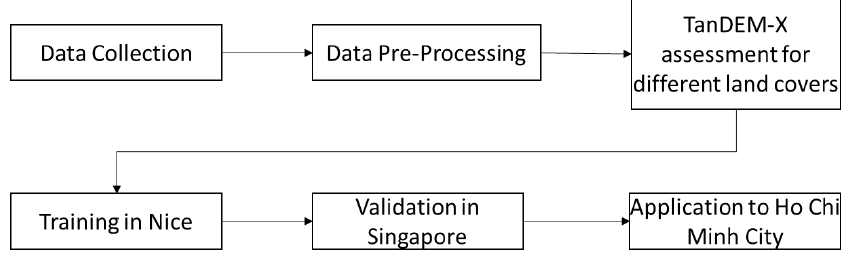
Figure 2. Flowchart of the methodology .